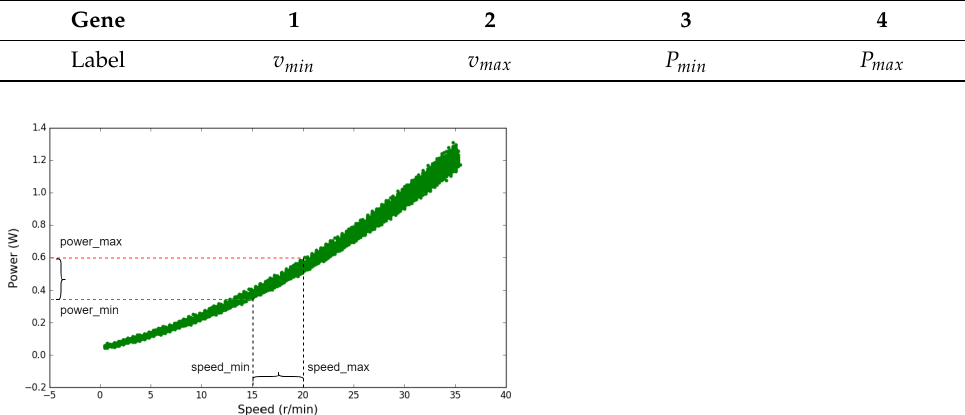
Table 1. The layout of a chromosome.